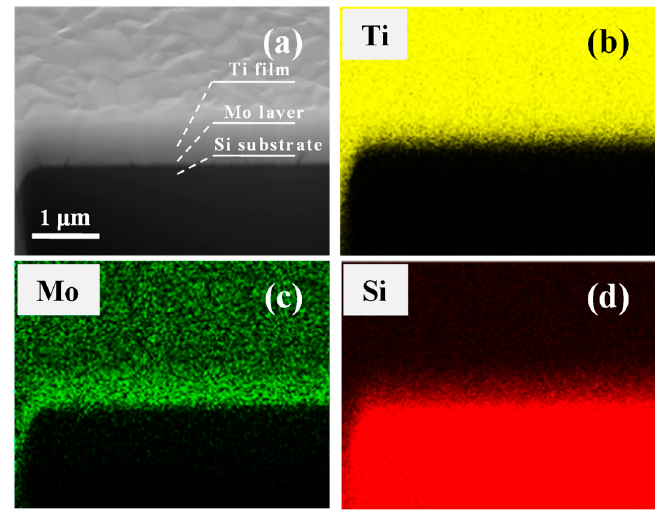
Figure 3. (Color online) ( a ) Cross-sectional SEM image of Mo-2 sample. ( b – d ) The Ti, Mo, and Si element distribution of (a) shows a clear Mo transition layer between the Ti film and Si substrate.